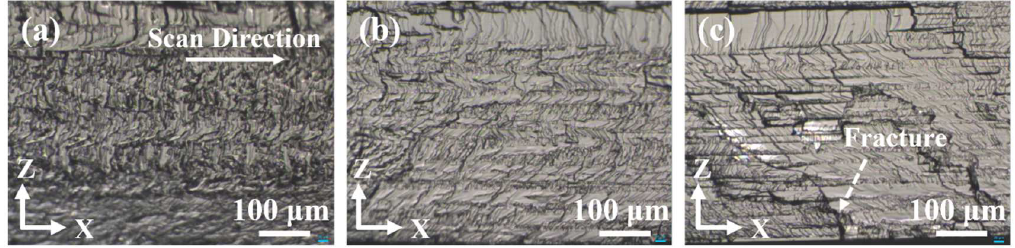
Figure 3. Morphology of cross sections with different pulse widths of ( a ) 1 ps, ( b ) 5 ps, and ( c ) 10 ps.